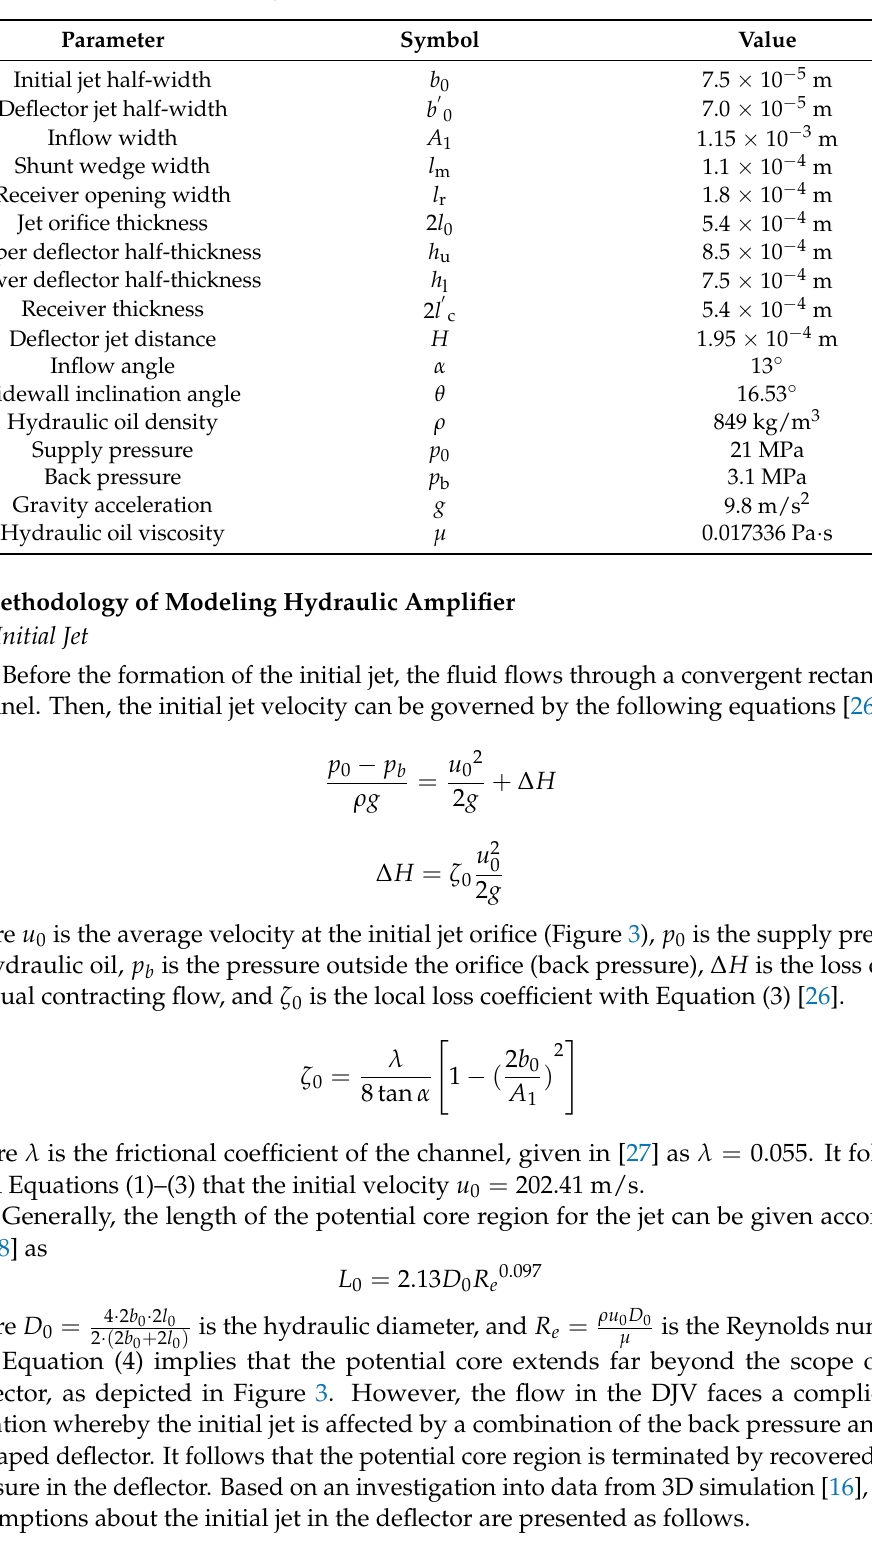
Table 1. Dimensions of deflector jet